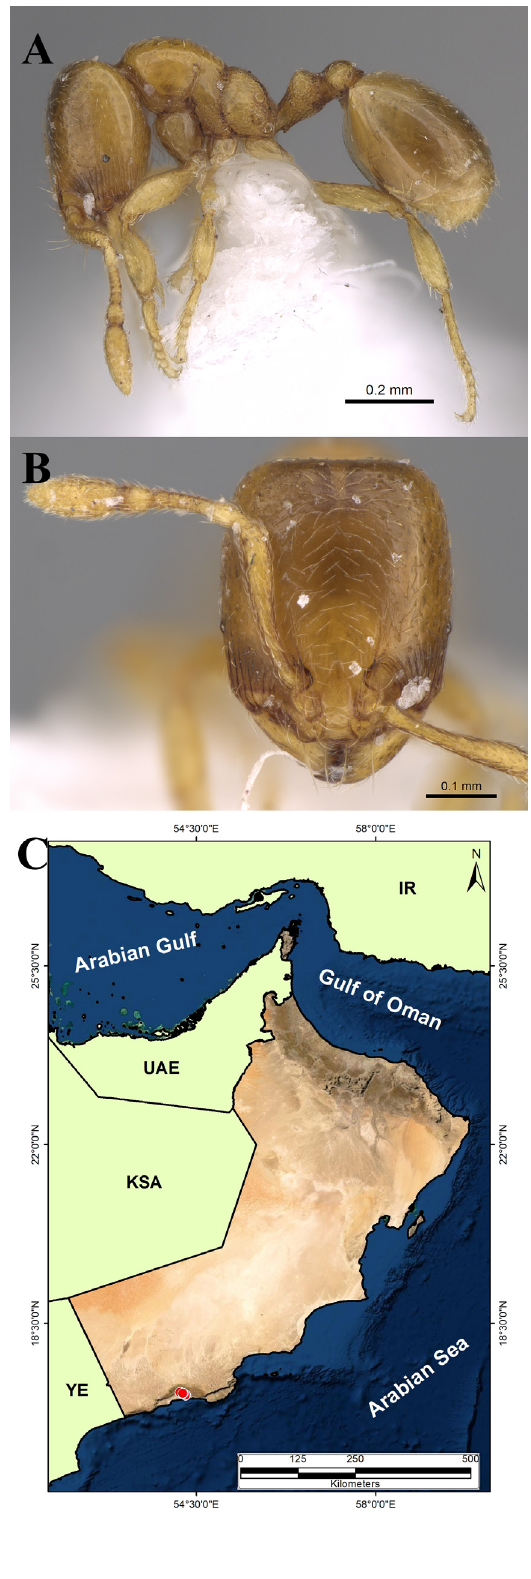
Fig. 29. Carebara arabica (Collingwood & van Harten, 2001), minor worker (CASENT0922870, AntWeb.org (Michele Esposito)). A . Body in profile. B . Head in full-face view. C . Distribution